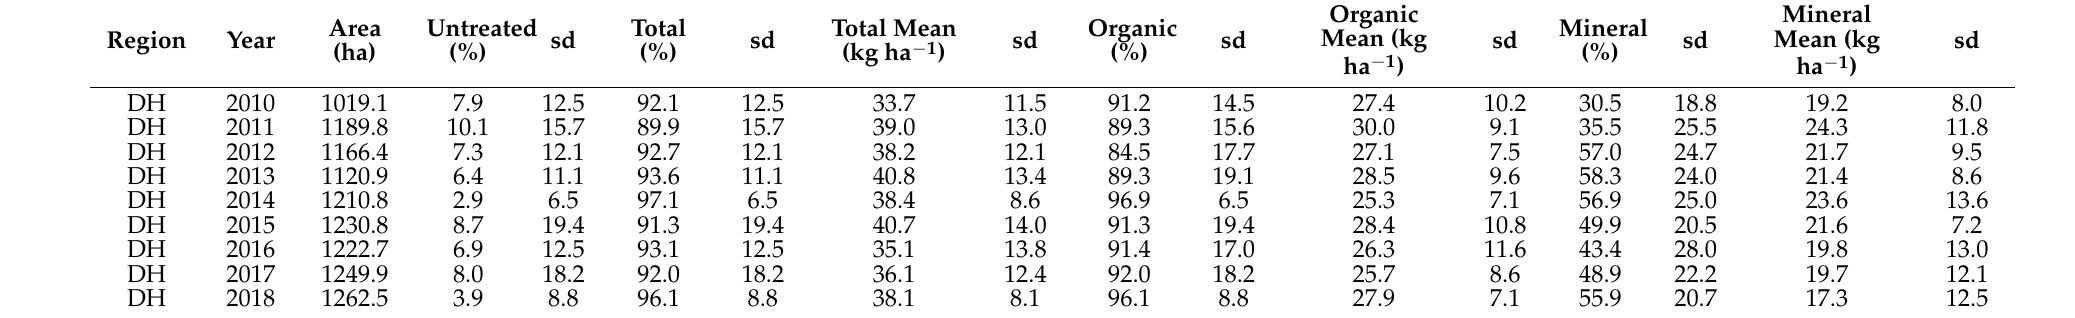
Table A3. Indicator frequency displayed in Figure 5 for untreated, total, mineral and organic treatment ± standard deviation (%). Indicator amount used on treated area ± standard deviation (kg ha − 1 ) is also displayed. DH: Diepholz, UE: Uelzen, RO: Rostock, FL: Fläming and OS: Oder-Spree. Area: total area (ha). Each farm contributes one value every year for frequency; for amount in some years some farms did not use P at all and, therefore, contributed no value.